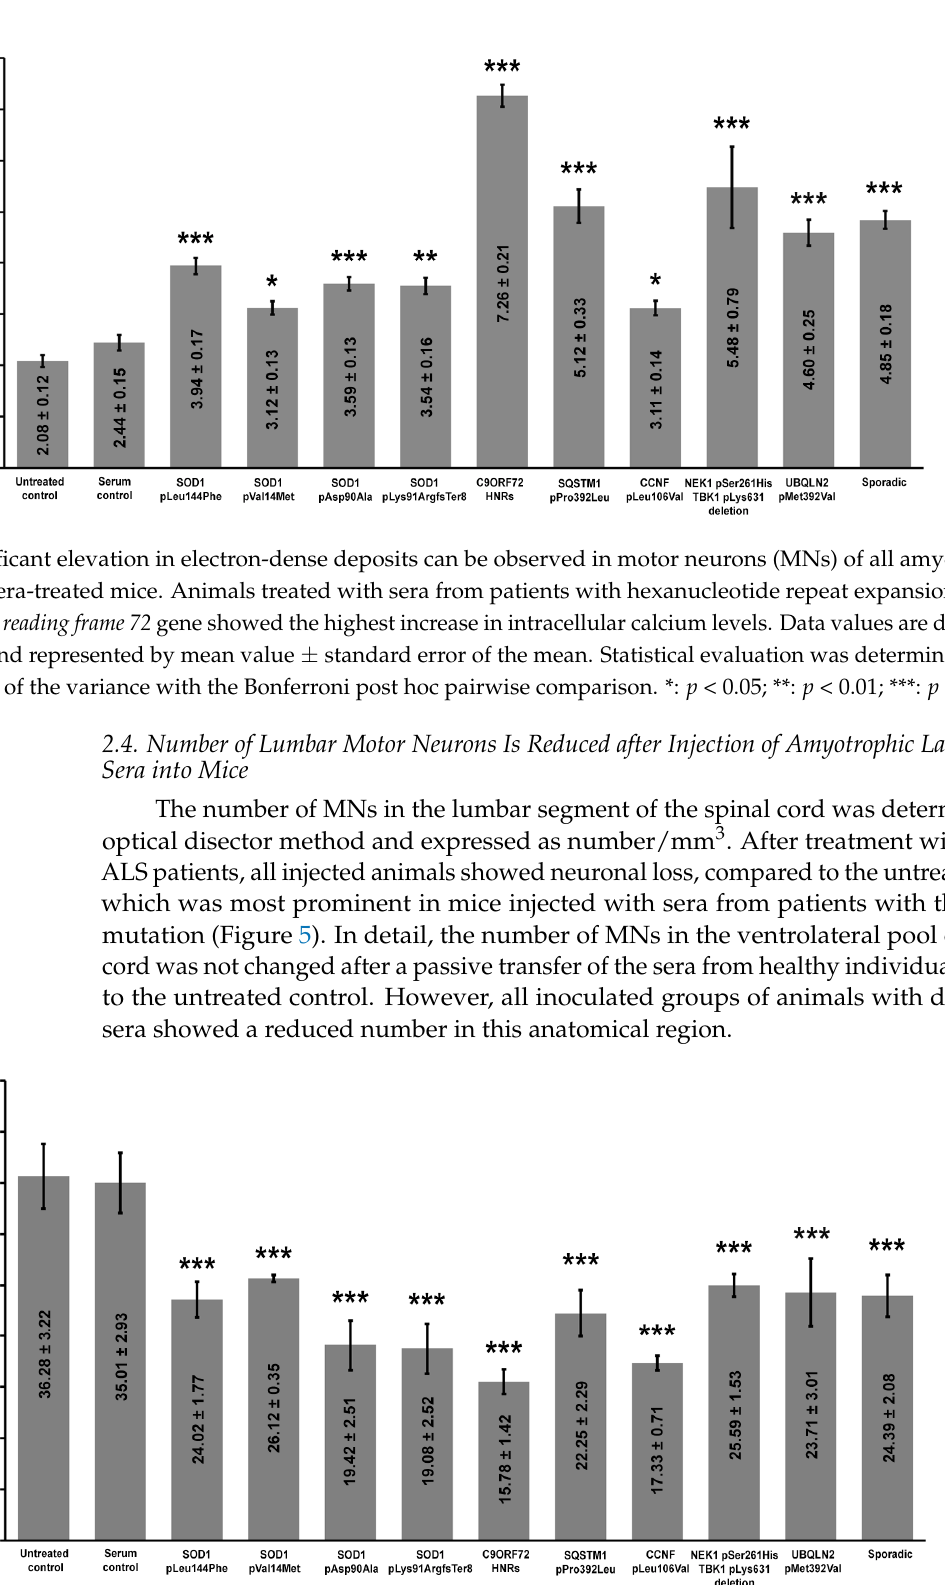
Figure 5. While there was no difference between the untreated and the healthy-sera-treated animals, the number of motor neurons was reduced in all amyotrophic lateral sclerosis sera-treated groups. Data values are displayed within the bars, and represented by mean value ± standard error of the mean. Statistical evaluation was determined using one-way analysis of the variance with the Bonferroni post hoc pairwise comparison. ***: p < 0.001.